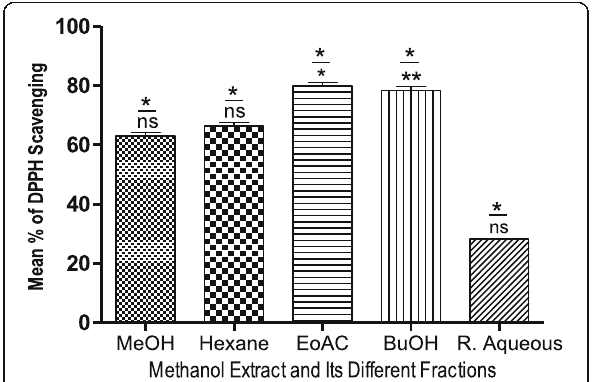
Fig. 3 Effect of TPC and TFC on DPPH Free Radical Scavenging Activity. Bars with ** P < 0.01, * P < 0.05 are Significantly Correlated whereas ns P > 0.05 Denotes Non significant Correlation According to Bonferroni Posttests (The Numerator on Bar Represent the Correlation with TPC and Denominator with TFC)